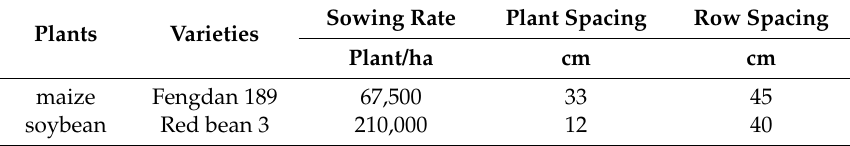
Table 1. Sowing rate of soybean and maize rotation in trial plots 2016–2017. Sowing Rate Plant Spacing Row Spacing Plants Varieties Plant/ha cm cm maize Fengdan 189 67,500 33 45 soybean Red bean 3 210,000 12